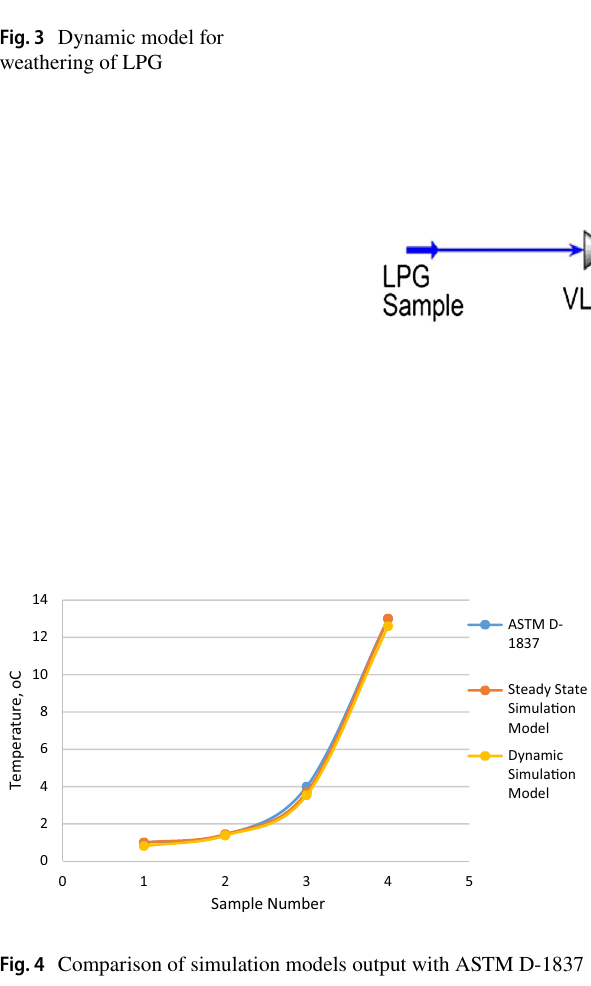
Fig. 4 Comparison of simulation models output with ASTM D-1837